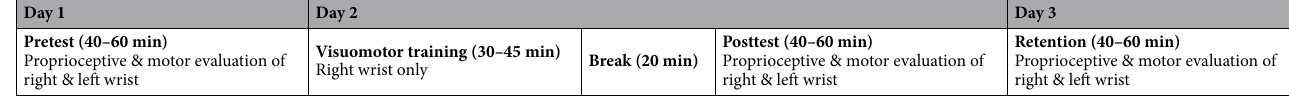
Table 1. Timeline and procedure of experimental